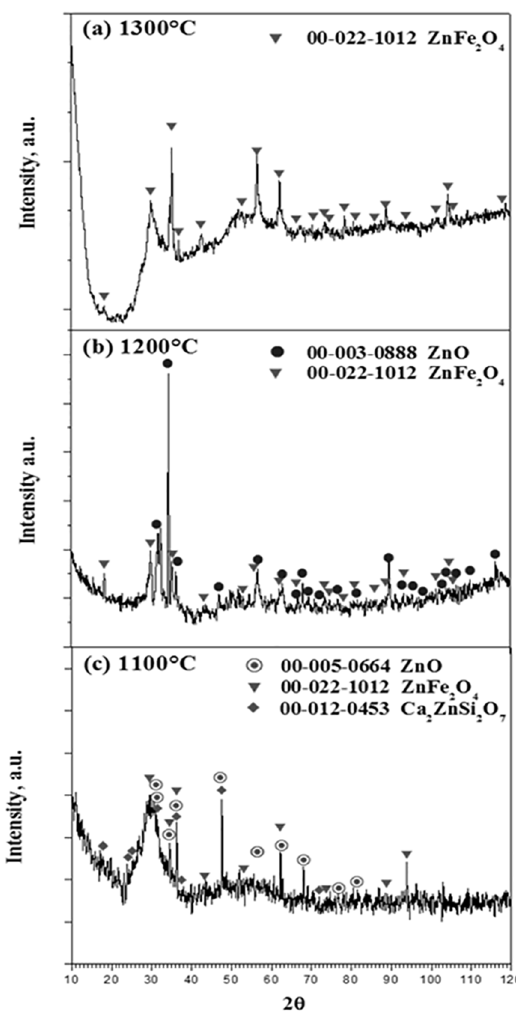
Figure 7. X-Ray diffraction patterns for slag sample 23 equilibrated at different temperatures.